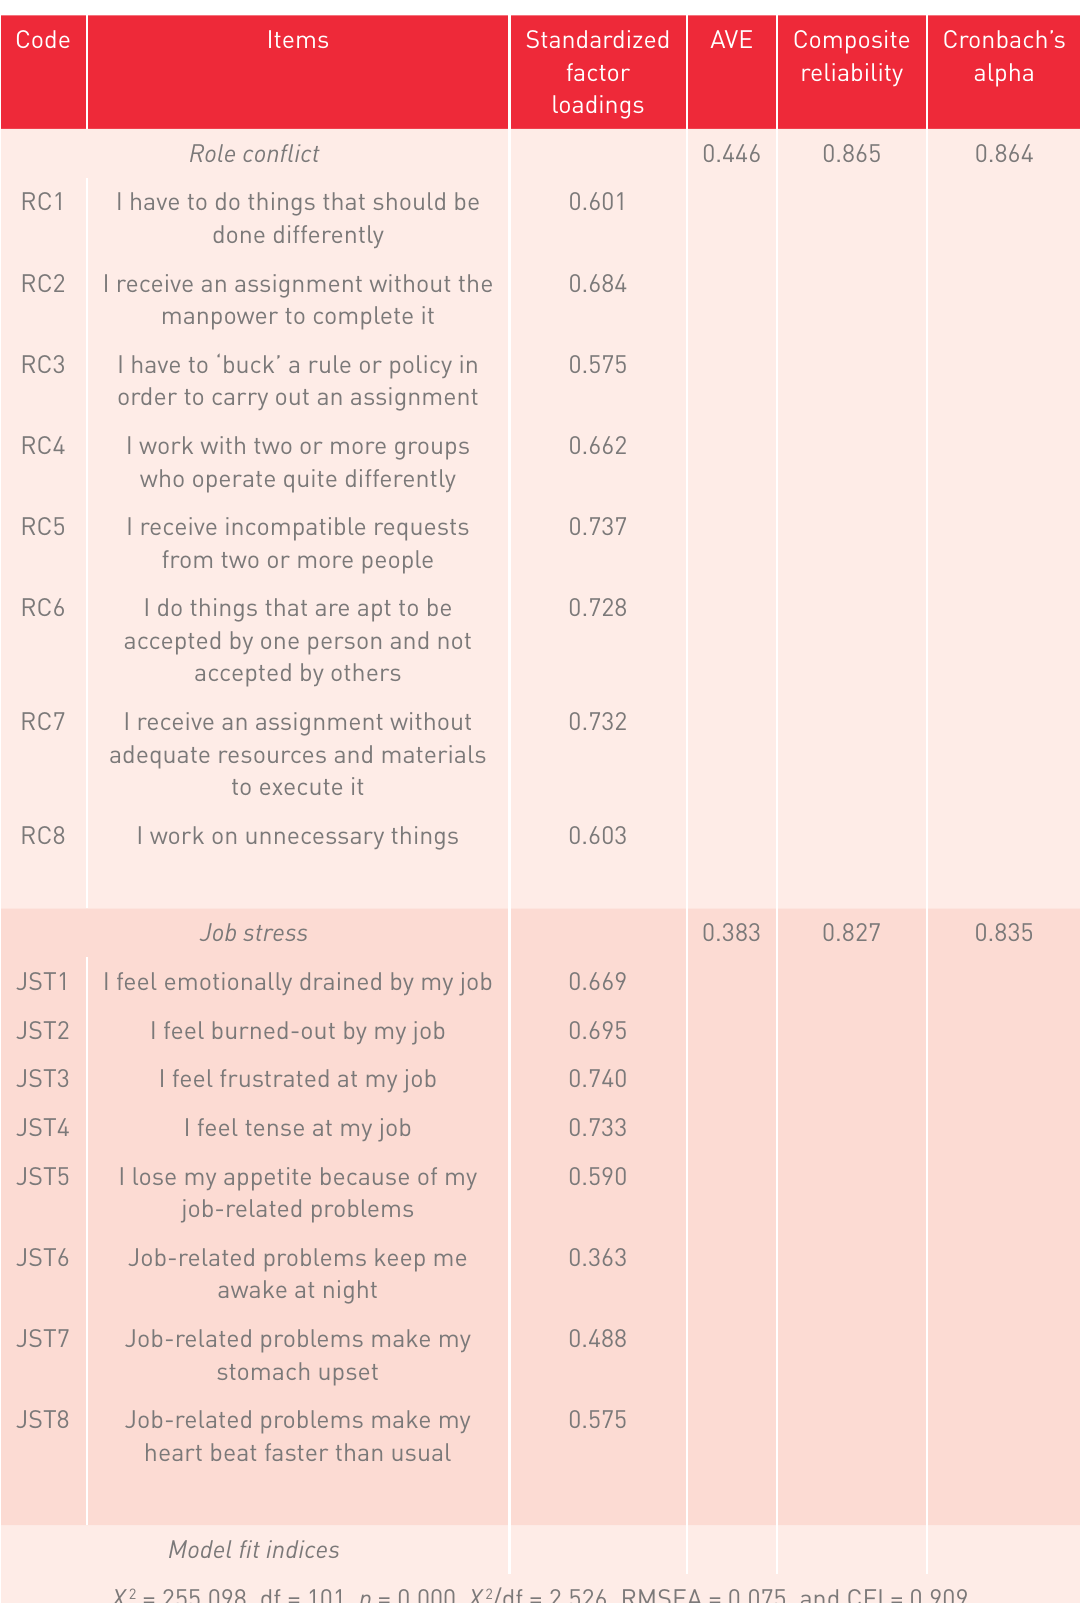
Table 2. Standardized factor loadings, AVE, internal reliability, and the fit statistics of the modified CFA